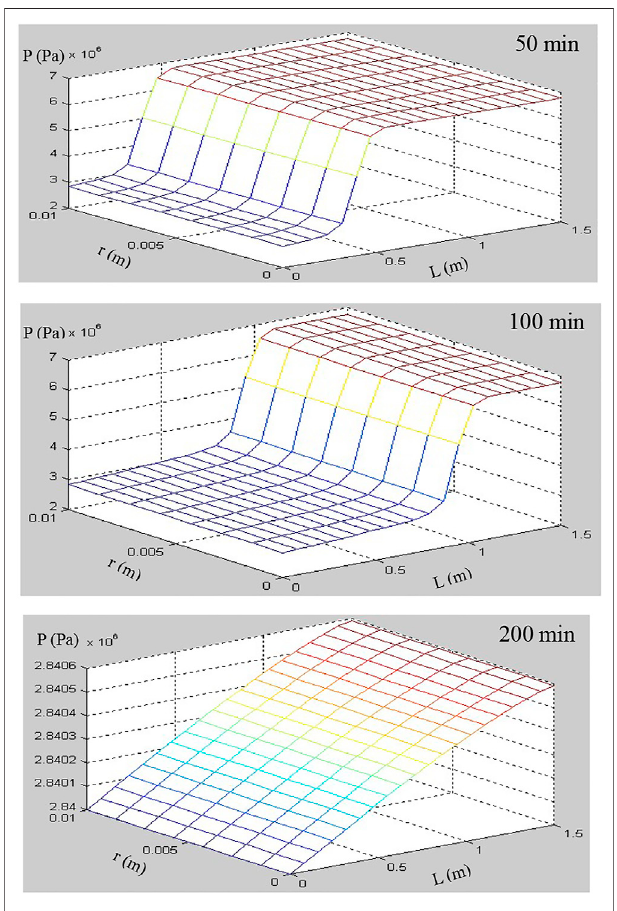
FIGURE 7 | Time evolution of pressure for the initial hydrate saturation of 70%.